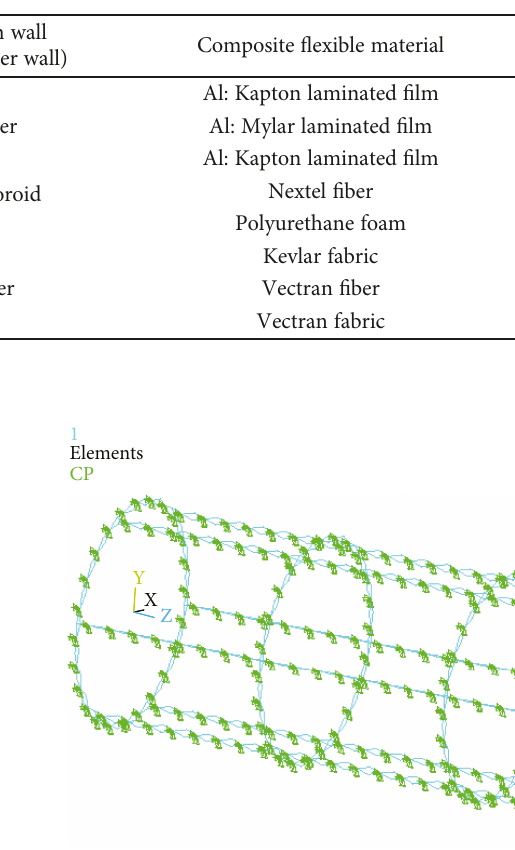
Table 1: Flexible composite shell of space-deployable habitat modules.